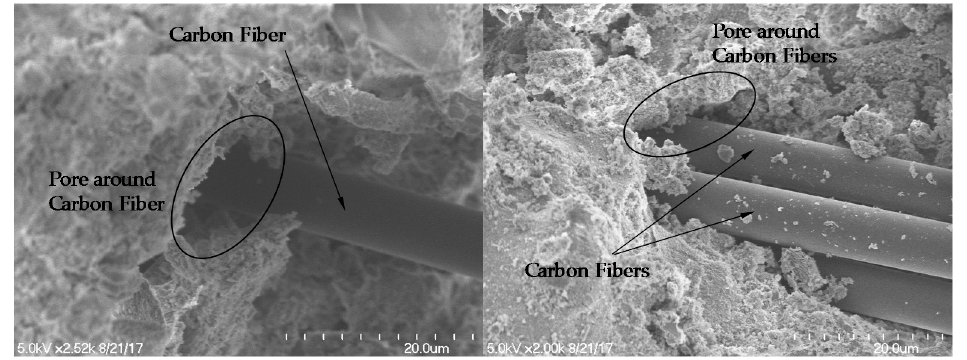
Figure 7. SEM images of cement-based composites with CFs.